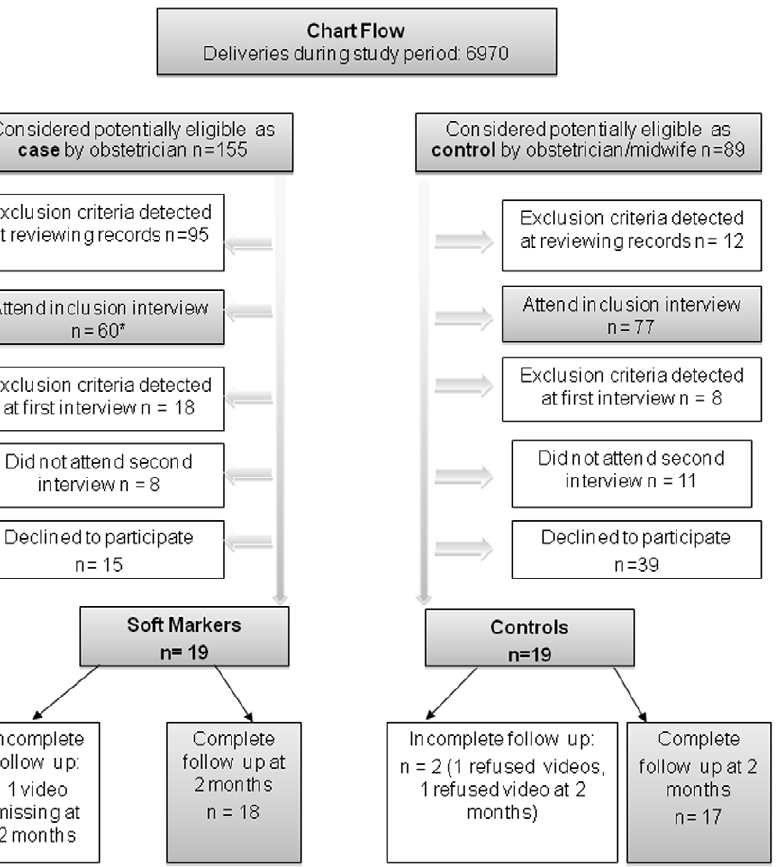
Figure 1. Diagram flow of the study. *Ultrasound soft markers included ventriculomegaly (N=8), increased nuchal translucency (N=16), Short OPN (N=4), echogenic bowel (N=19), echogenic intracardiac focus (N=2), mild pyelectasis (N=9), and short femur length (N=2).